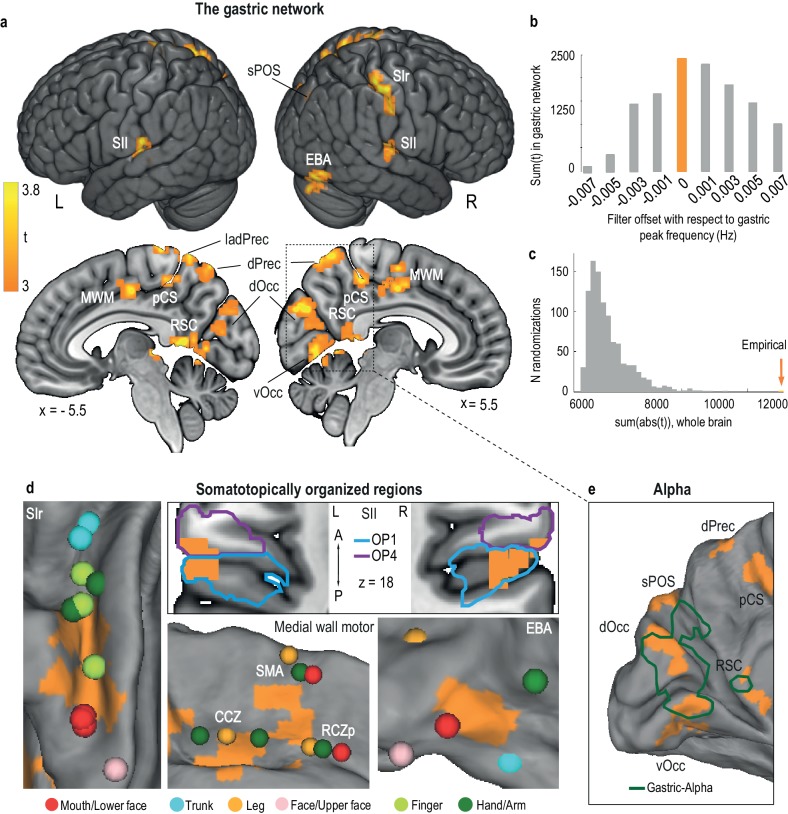
The gastric network.(a) Regions significantly phase synchronized to gastric rhythm (n = 30, voxel level threshold, p<0.01 two-sided; cluster level threshold, p<0.05, two-sided, intrinsically corrected for multiple comparisons). (b) Gastric-BOLD coupling is specific to gastric frequency. Summary statistics in the gastric network are maximal at the EGG peak frequency (orange) and decrease when offsetting the filter to higher or lower frequencies. (c) Summary statistics distribution under the null hypothesis from 1000 surrogate datasets in which the EGG signal was time-shifted with respect to the BOLD signal. The empirical finding (orange arrow) falls well outside the null distribution. (d) The gastric network (orange) comprises the following somatotopically organized regions: primary somatosensory cortex (Panel SI, with peak activations during stimulation of the trunk and hand (Fabri et al., 2005), finger (Weibull et al., 2008), face (Kopietz et al., 2009), and mouth, that is, teeth (Trulsson et al., 2010), lips and tongue (Miyamoto et al., 2006); secondary somatosensory cortex (Panel SII, cytoarchitectonic subdivisions of SII according to (Scheperjans et al., 2008); OP1, parietal operculum 1 and OP4, parietal operculum 4, presented on a horizontal slice at z = 18); medial wall motor areas (Panel MWM, with peak activations during movement (Amiez and Petrides, 2014) in the caudate cingulate zone (CCZ), posterior rostral cingulate zone (RCZp) and supplementary motor area (SMA)); and extrastriate body area (Panel EBA with peak activations during body part viewing (Orlov et al., 2010), note that because of the visualization on an inflated cortex, the extension of the EBA node to the cerebellum is not visible). (e) Regions in which the alpha and gastric rhythms are coupled (green, modified from [Richter et al., 2017]). Abbreviations are the same as those in Table 1.10.7554/eLife.33321.007Figure 2—source data 1.csv file containing the sum of t in gastric network resulting from filtering the EGG and the BOLD signal with an offset with respect to gastric peaking frequency, used for Figure 1b.10.7554/eLife.33321.008Figure 2—source data 2.csv file containing the sum of abs(t) in the whole brain for each randomization of time-shift of the EGG, used for Figure 1c.